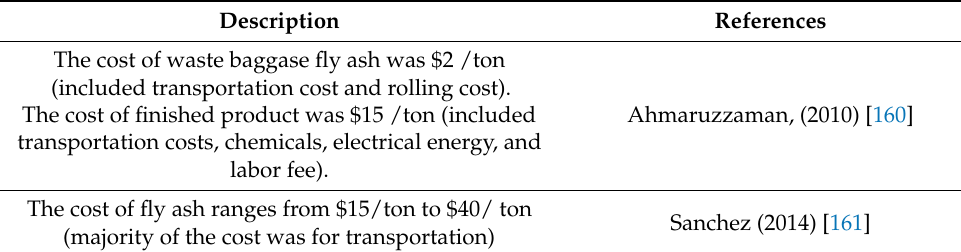
Table 11. The preparation costs and operation costs of fly ash.